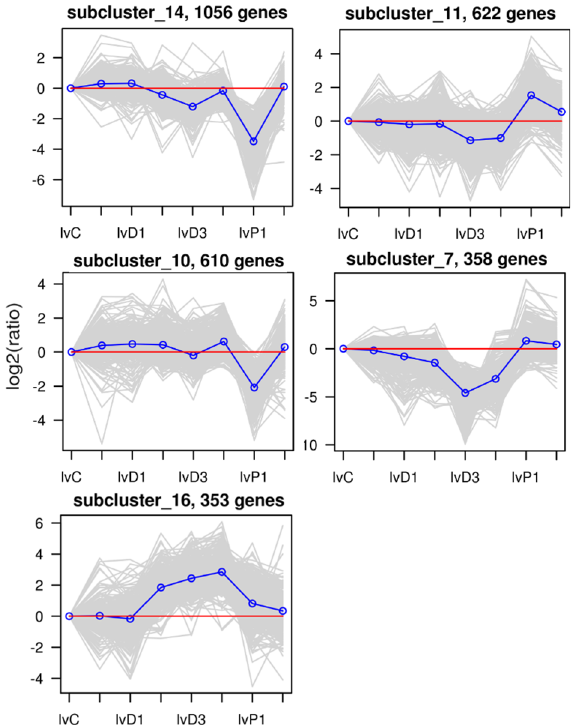
Fig 3. The top five clusters determined by K-means clustering, including 2,999 DEGs (58.6% of all genes). The x-axis indicates the molting stage. The y-axis indicates the log 2 (ratio) of gene expression. Each grey row represents the relative expression of DEGs in a cluster. The blue line represents the average value of all members. The red line denotes reference, the line above the red line represents up-regulation, and the line below the red line represents down-regulation. The number of DEGs within a cluster is shown after that